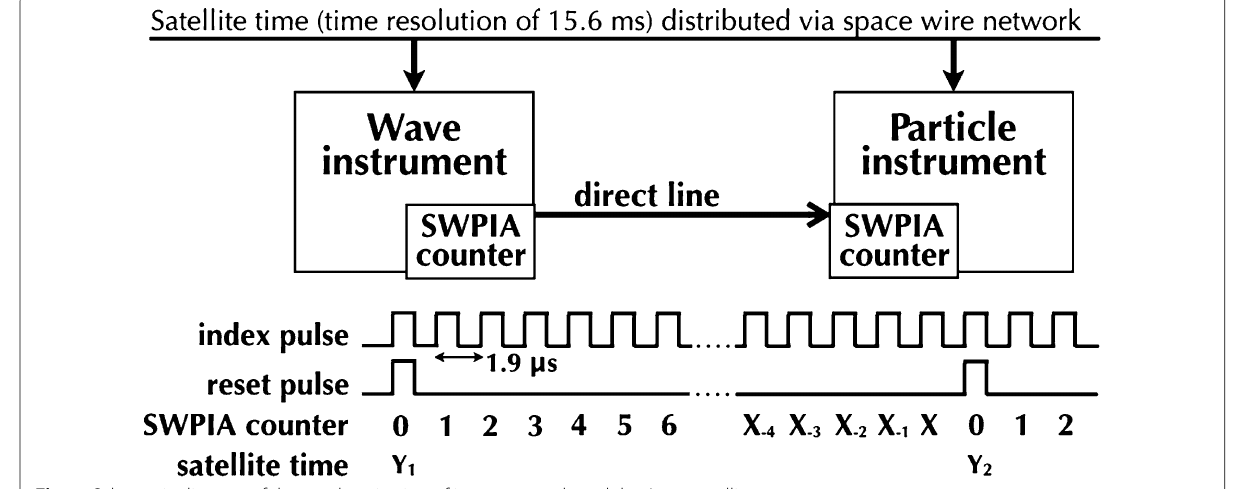
Fig. 4 Schematic diagram of the synchronization of instruments aboard the Arase